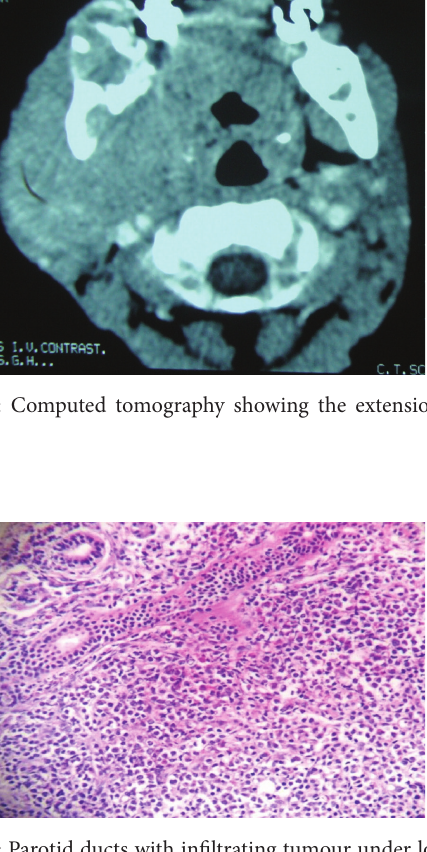
Figure 2: Parotid ducts with infiltrating tumour under low-power view.